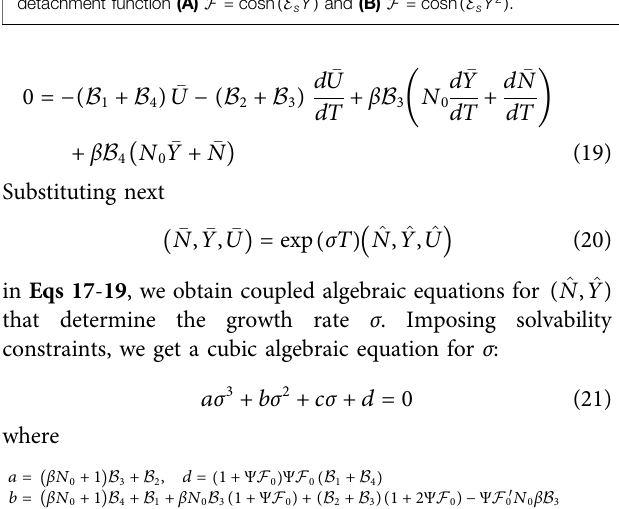
FIGURE 2 | The mean motor extension Y and fraction of motors that are attached N as a function of Z steady solutions to Eqs 13 , 14 for two forms of the detachment function (A) F (cid:2) cosh ( E s Y ) and (B) F (cid:2) cosh ( E s Y 2 ) .